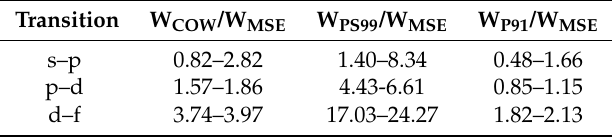
Table 3. Ranges of values of ratios of W COW , W PS99 and W P91 with W MSE for different types of